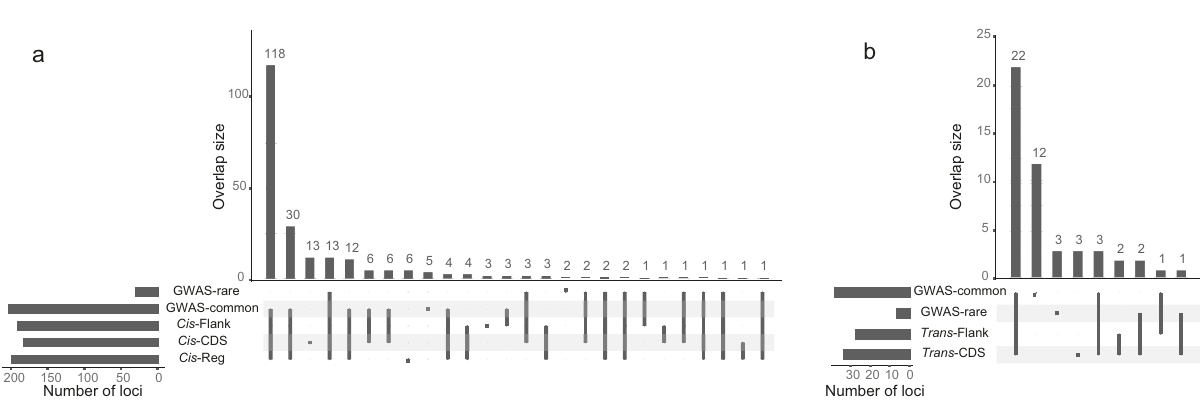
Fig. 3 Overview of the SNV-sets, and SKAT tests performed, as well as overlap between the results. a Overview of the SNV-sets, SKAT tests performed, and overlap between the results for the different SNV-sets. The Venn diagram shows the number of overlapping loci with any signi fi cant SKAT association between the different SNV-sets. For Cis -associations a p -value of 5.88 × 10 – 6 was considered as threshold for signi fi cance, while for Trans - associations a threshold p -value of 4.67 × 10 – 10 was adopted. b Fraction of loci identi fi ed in the different models within each SNV-sets. A total of 198, 190, 182, 33, and 27 loci were identi fi ed with the fi ve SNV-sets, respectively ( N in the legend). Each bar represents the fraction of these N loci that were signi fi cant for the different SKAT models. The seven models are: (1) Unweighted; (2) CADD or Eigen weighted; (3) MAF weighted, β (1, 25); (4) MAF weighted, β (1, 5); (5) MAF weighted, β (0.5, 0.5); (6) CommonRare; (7) Rare only.